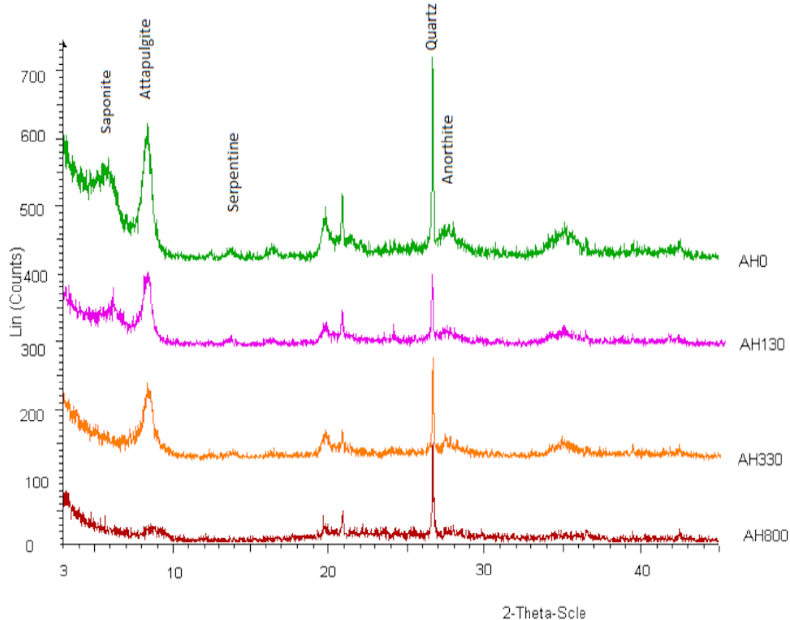
Figure 1. XRD diagrams of raw (AH0) and heat-treated (at 130 ° C, 330 ° C, and 800 ° C) attapulgite clay.